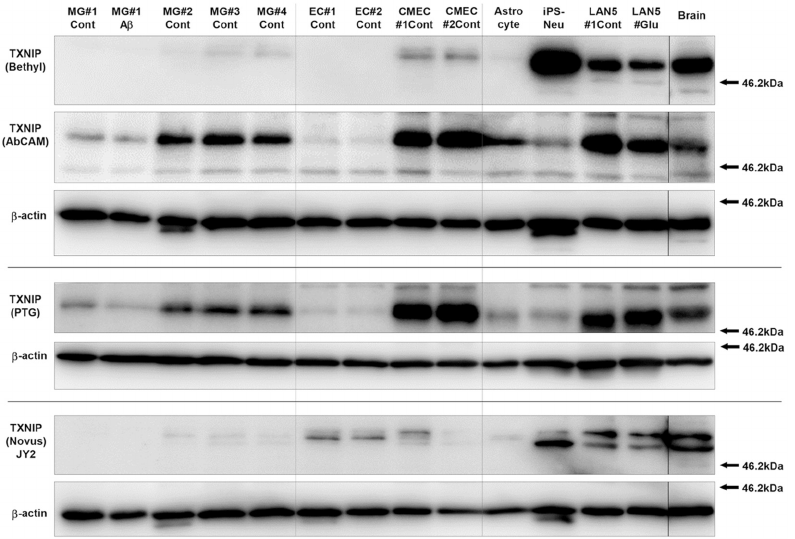
Figure 2. Comparison of TXNIP recognition patterns with antibodies from different sources in different brain-derived cells. Parallel immunoblot membranes with the same amounts of cellular proteins were probed with optimal dilution of four commercial TXNIP antibodies. The results show varying recognition patterns. Equivalent loading between cellular samples is demonstrated with reprobing blots for β -actin. The blot showing results of using AbCAM TXNIP antibody had previously been probed with TXNIP Bethyl antibody Abbreviations: MG, extracts from control (Cont) and A β treated microglial extracts from different cases (1,2,3); EC, extracts from primary human brain-derived endothelial cells; MEC, extracts from transformed brain endothelial cell line hCMEC/D3; Astrocyte, extract from brain derived primary astrocytes; iPS-Neu, extracts from Cellular Dynamics iCell human stem cell-derived human neurons; LAN5, extracts from differenti- ated human neuroblastoma cell line LAN-5 control (Cont) or high-glucose treated (Glu); Brain, extract of human brain samples from AD middle temporal gyrus (MTG).